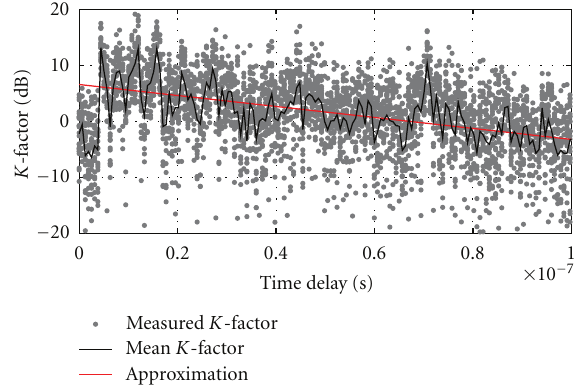
Figure 4: Extraction of the powers associated with the coherent (blue line) and di ff use (black line) components. The red dotted line presents the exponential model used to characterize the di ff use component. The example presented here is the case with two passengers.